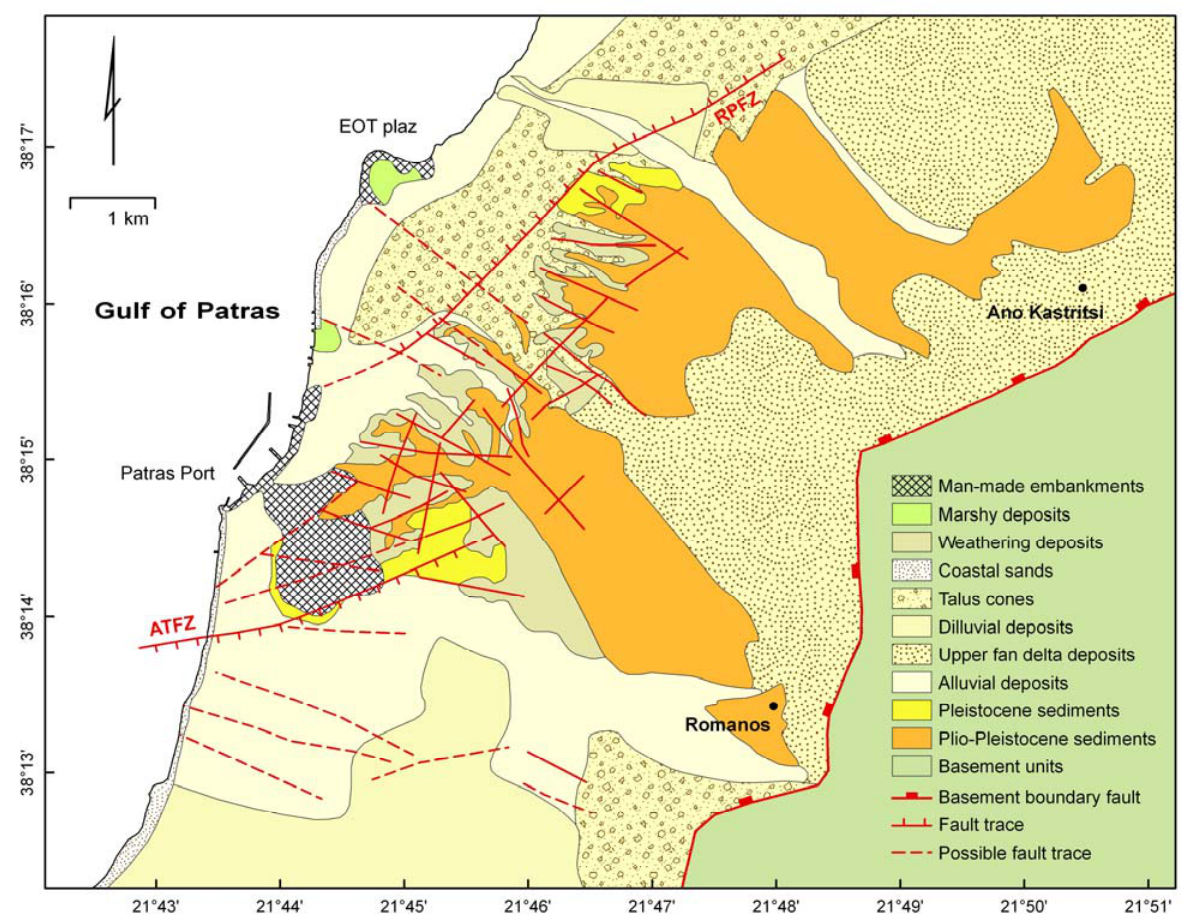
Figure 2. Geological map of Patras City (ATFZ: Ag. Triada Fault Zone, RPFZ: